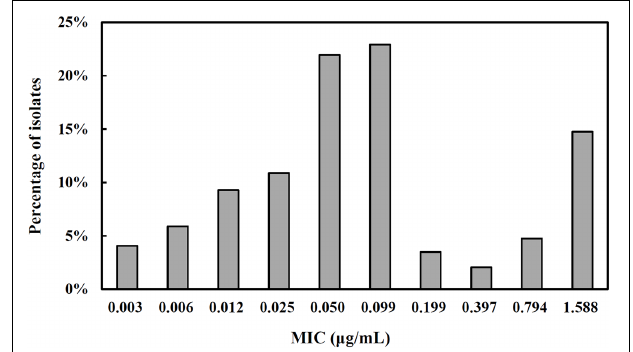
FIGURE 5 | The MIC distribution for tulathromycin against S. suis ( n = 441). The isolates were obtained from our own laboratory in combination with data from some previous studies (El Garch et al., 2016; Sweeney et al., 2017). All reported MIC in broth matrix was transformed into equivalent MICs in serum by a scaling factor of 40.3 to take into account the serum